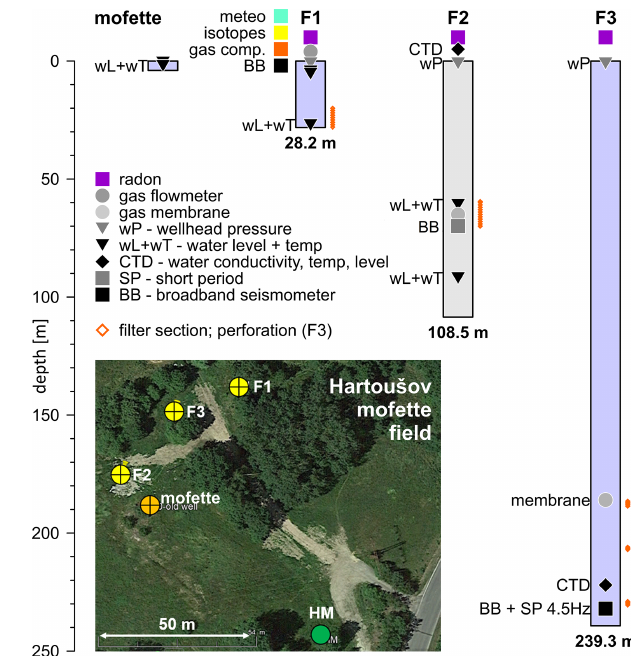
Figure 7. Fluid and seismic monitoring in the Hartoušov mofette field (after Woith et al., 2020), showing boreholes F1–F3 and a mofette site with the sensors and types of monitoring. BB denotes a broadband seismometer (borehole and/or surface), and SP repre- sents a short-period 4.5Hz 3C borehole